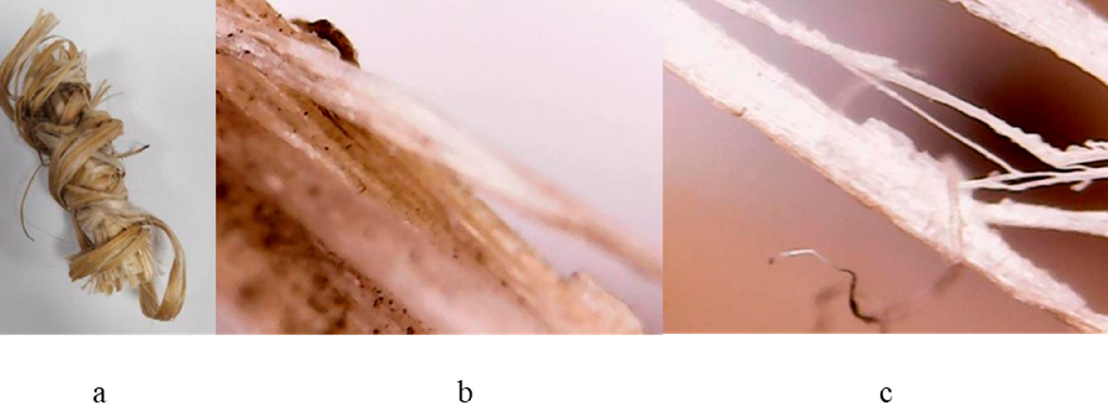
Figure 10. Crushed hemp stalk used as a target in the PLD process ( a ) and images with an optical microscope of the irradiated crushed hemp stalk ( b , c ).